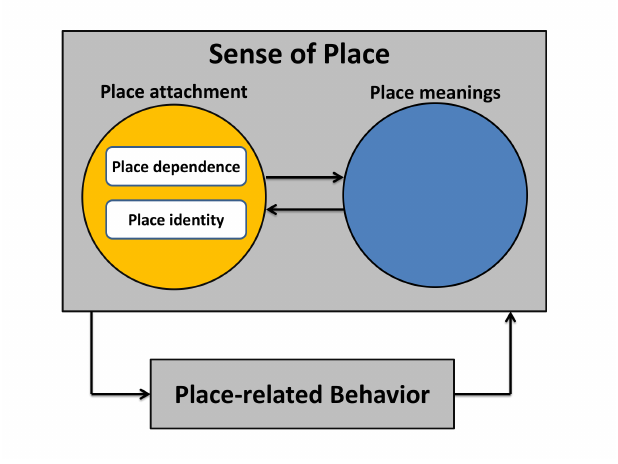
Fig. 1. The relationships among key sense of place